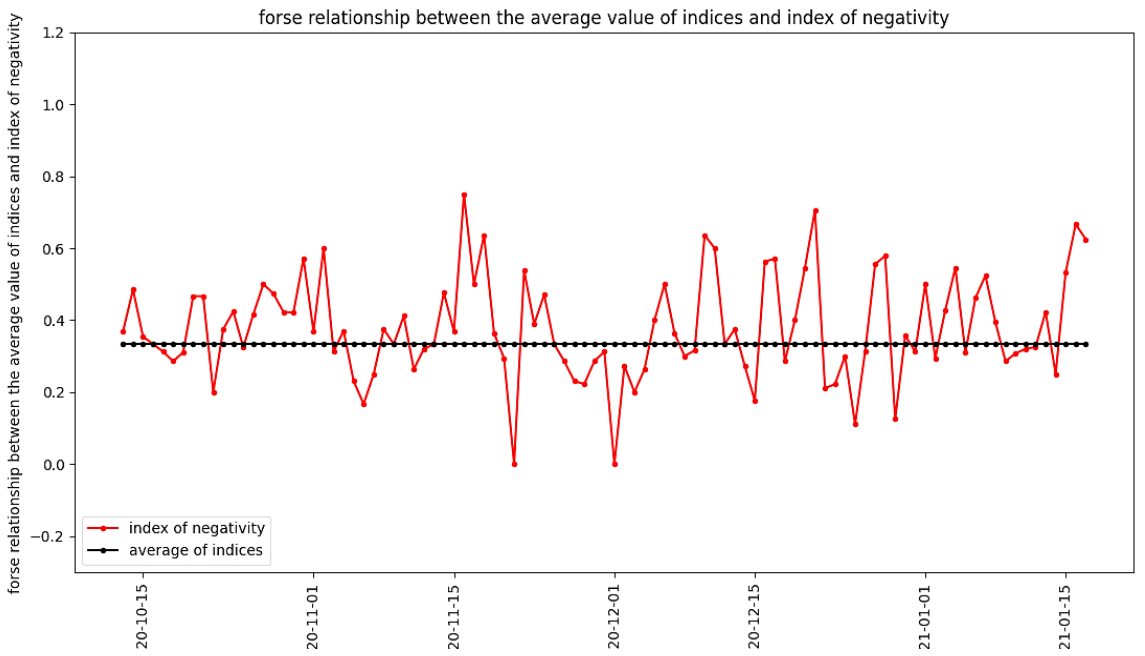
Figure 2. Average of the indices and index of